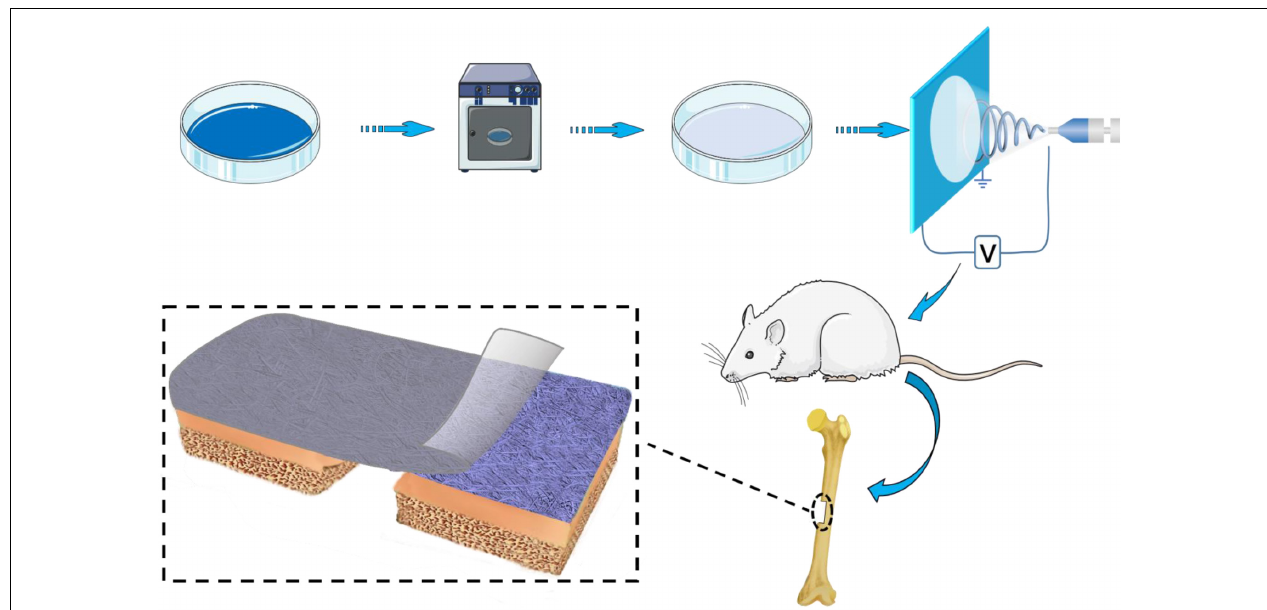
FIGURE 1 | Schematic illustration of the method of preparation and implantation of the BER@PCL/PVP-MC/CS bilayer membrane.